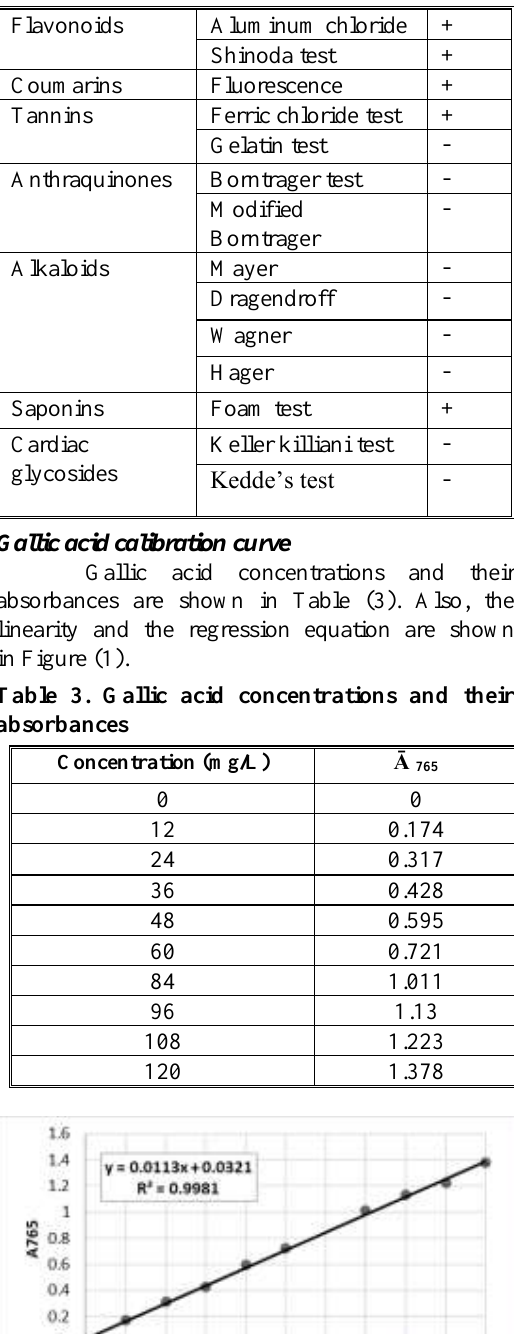
Table 2. Phytochemical identification of E. polyceras roots